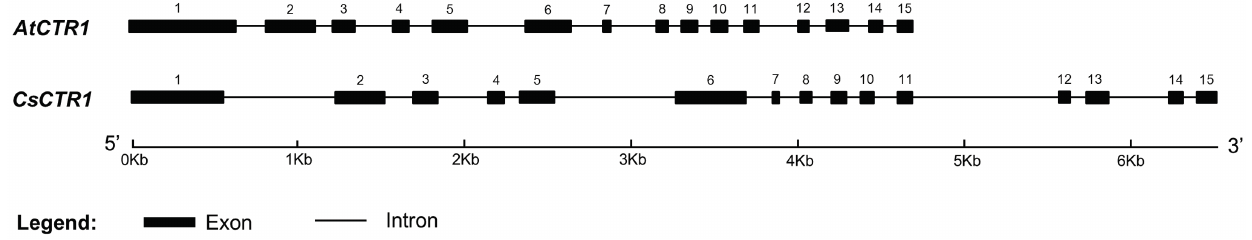
Figure 1. Comparison of the genomic structure of cucumber CsCTR1 (JQ277220) and the Arabidopsis AtCTR1 gene (L08790). Black portions represent the exons, straight lines represent the